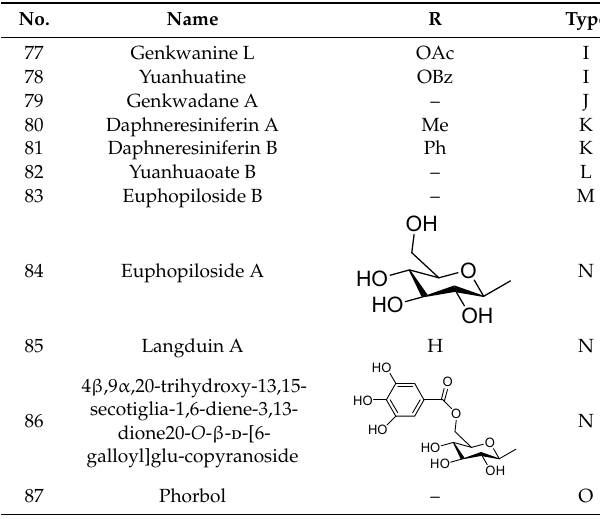
Figure 3. Seven types ( I – O ) of resiniferonoids skeletons. Figure 3. Seven types (I-O) of resiniferonoids skeletons. Figure 3. Seven types (I-O) of resiniferonoids skeletons. Figure 3. Seven types (I-O) of resiniferonoids skeletons. Table 3. Reported structures of resiniferonoids skeletons. Table 3. Reported structures of resiniferonoids skeletons. Table 3. Reported structures of resiniferonoids Table 3. Reported structures of resiniferonoids skeletons.